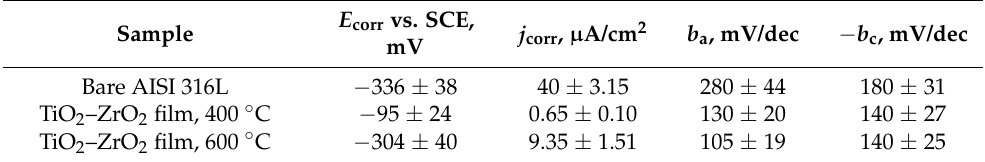
Figure 8. Potentiodynamic curves of bare AISI 316L stainless steel and steel with TiO 2 –ZrO 2 film Table 5. Electrochemical parameters obtained from potentiodynamic polarization curves measured in 0.5 mol dm − 3 HCl solution (mean value ± standard